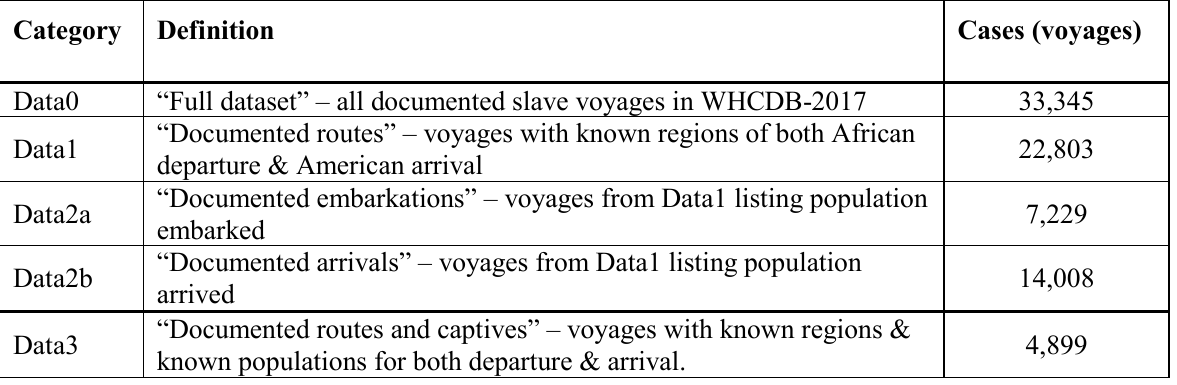
Table 6. Sub-datasets for known data in WHCDB-2017